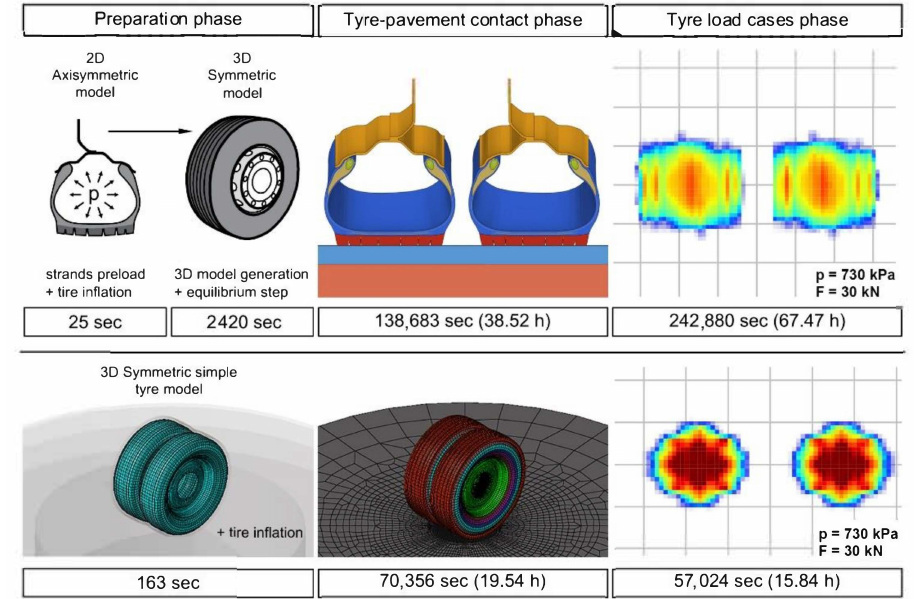
Figure 8. Comparison of the running time of simulation phases of complex and simple tyre models, where the top row shows the complex tyre model and the bottom row shows the simple tyre